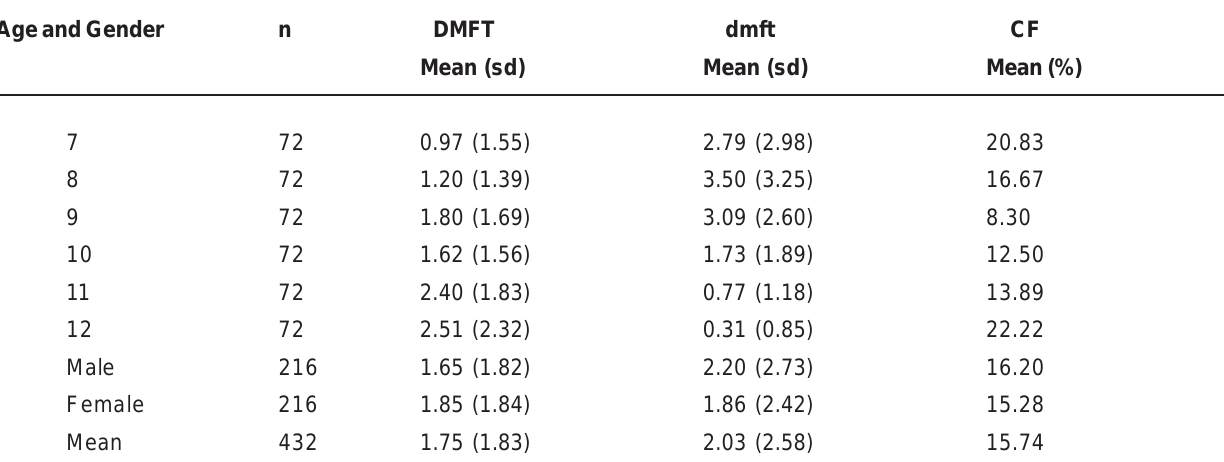
TABLE 1- Mean DMFT, mean dmft (standard deviations) according to age and gender and percentage of 7-12-year-old caries-free (CF) schoolchildren in Catalão, 2001